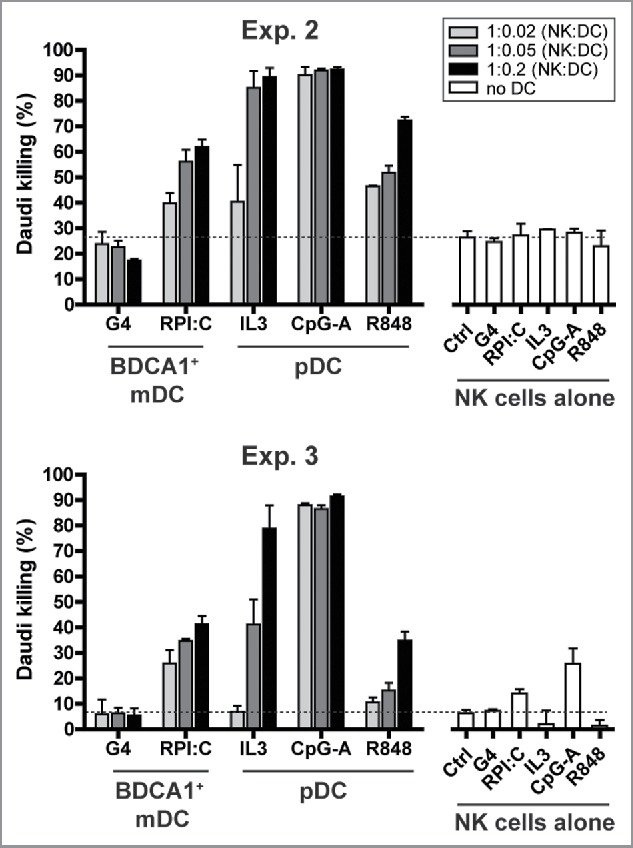
HSPC-pDCs superiorly potentiate cytolytic capacity of NK cells. NK cells were co-cultured with DCs for 40 h as described in Fig. 5. Subsequently, a 4 h flow cytometric cytotoxicity assay was performed, where Daudi tumor cells were added at a NK:Daudi ratio of 1:0.5. The graphs depict percentage of specific killing (mean ± SD of triplicates), and was calculated as follows: 100 – ((absolute number of viable CFSE+ Daudi cells cocultured with NK cells/absolute number of viable CFSE+ Daudi cells cultured alone) × 100). Data depicted are from the same two experiments as are described in Fig. 5B–C. Exp. = Experiment.